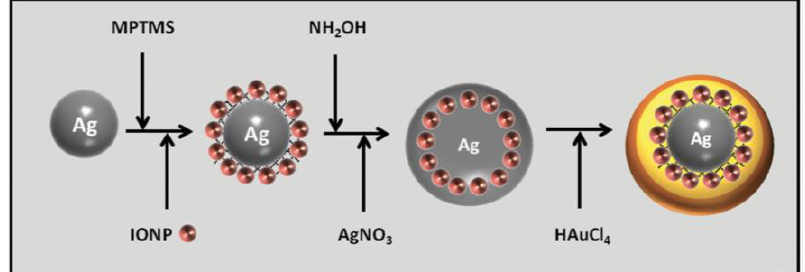
Figure 15. Synthesis of magnetic hollow gold nanoshells. Reprinted with permission from Reference [71]. Copyright (2014) John Wiley and Sons.